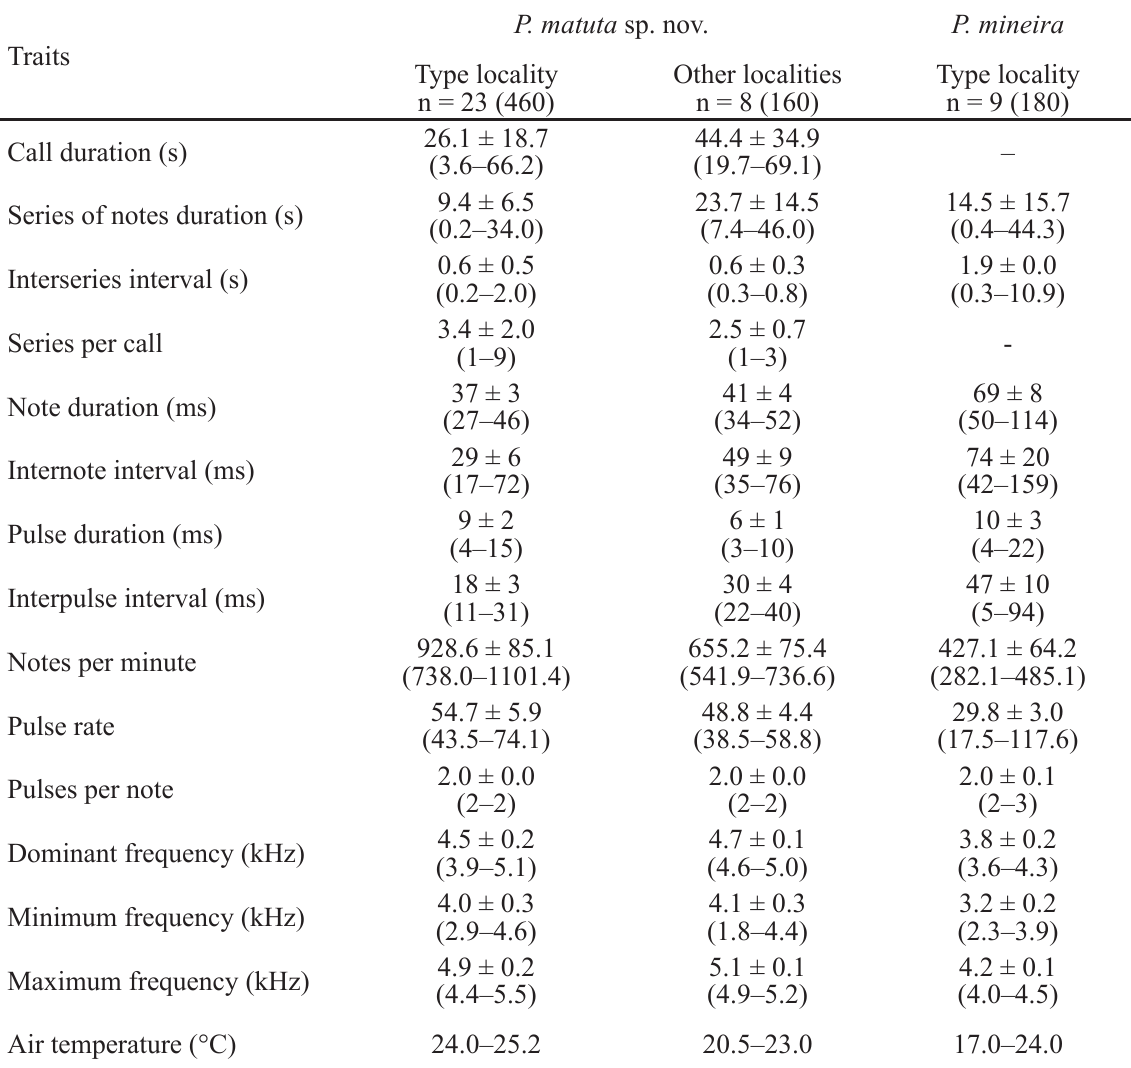
Table 2. Advertisement call traits of Pseudopaludicola matuta sp. nov. from the type locality, lowlands of the Serra do Cipó National Park (southern foothills), municipality of Santana do Riacho, and municipality of Belo Horizonte; and of P. mineira Lobo, 1994 from its type locality, in the highlands of Serra do Cipó; all in the Brazilian state of Minas Gerais. Mean ± SD (minimum–maximum); n = number of males recorded (number of analysed